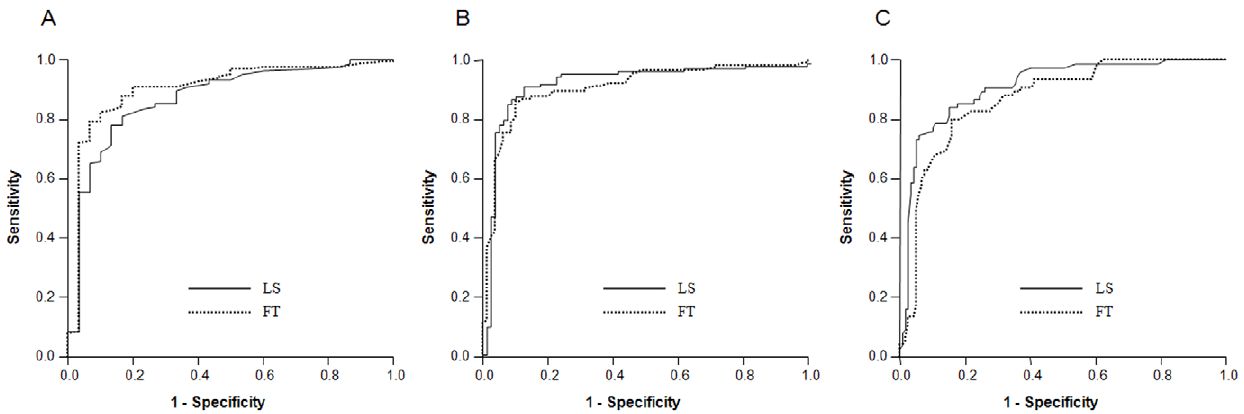
Figure 3. Receiver operating characteristic (ROC) curves for LS and FT in the diagnosis of significant fibrosis ( $ F2, A), advanced fibrosis ( $ F3, B), and cirrhosis (F=4,